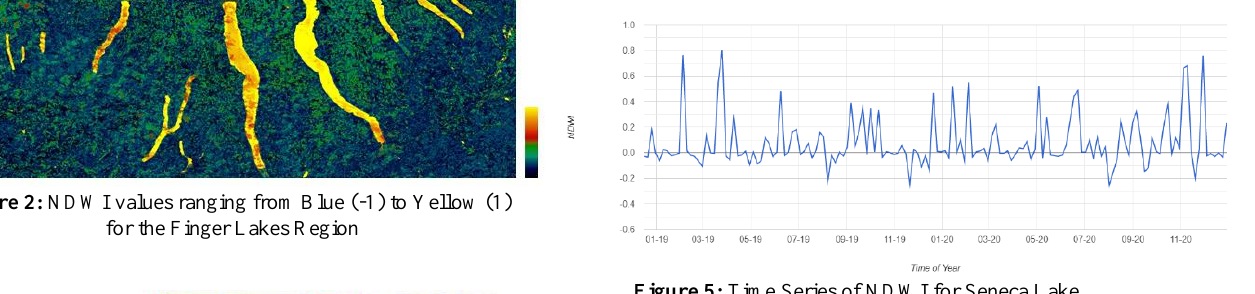
Figure 5: Time Series of NDWI for Seneca Lake